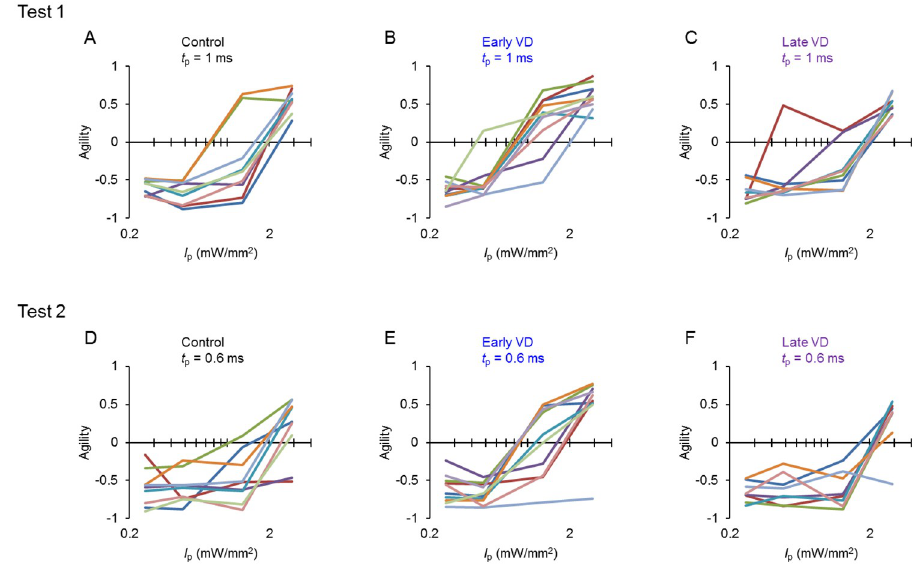
Fig 5. The shift of agility during test 1 and test 2. A-C , The changes of agility during test 1, each color indicates an individual rat in the control (A, n = 9), early VD (B, n = 10) and late VD (C, n = 8) groups. D-F , Similar to A-C, but during test 2, the control (D, n = 10), early VD (E, n = 9) and late VD (F, n = 8) groups.